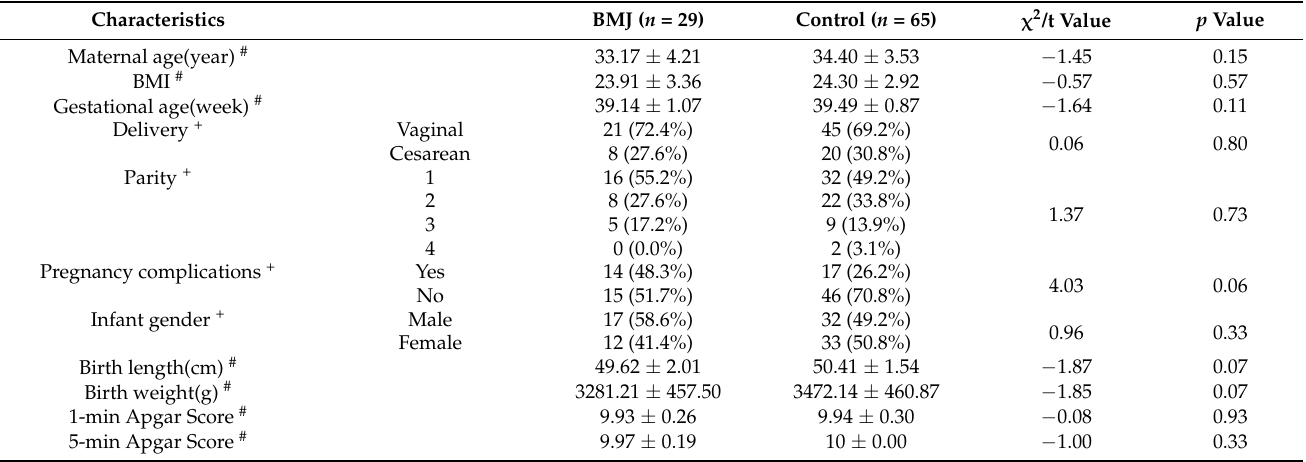
Table 1. Characteristics of the study